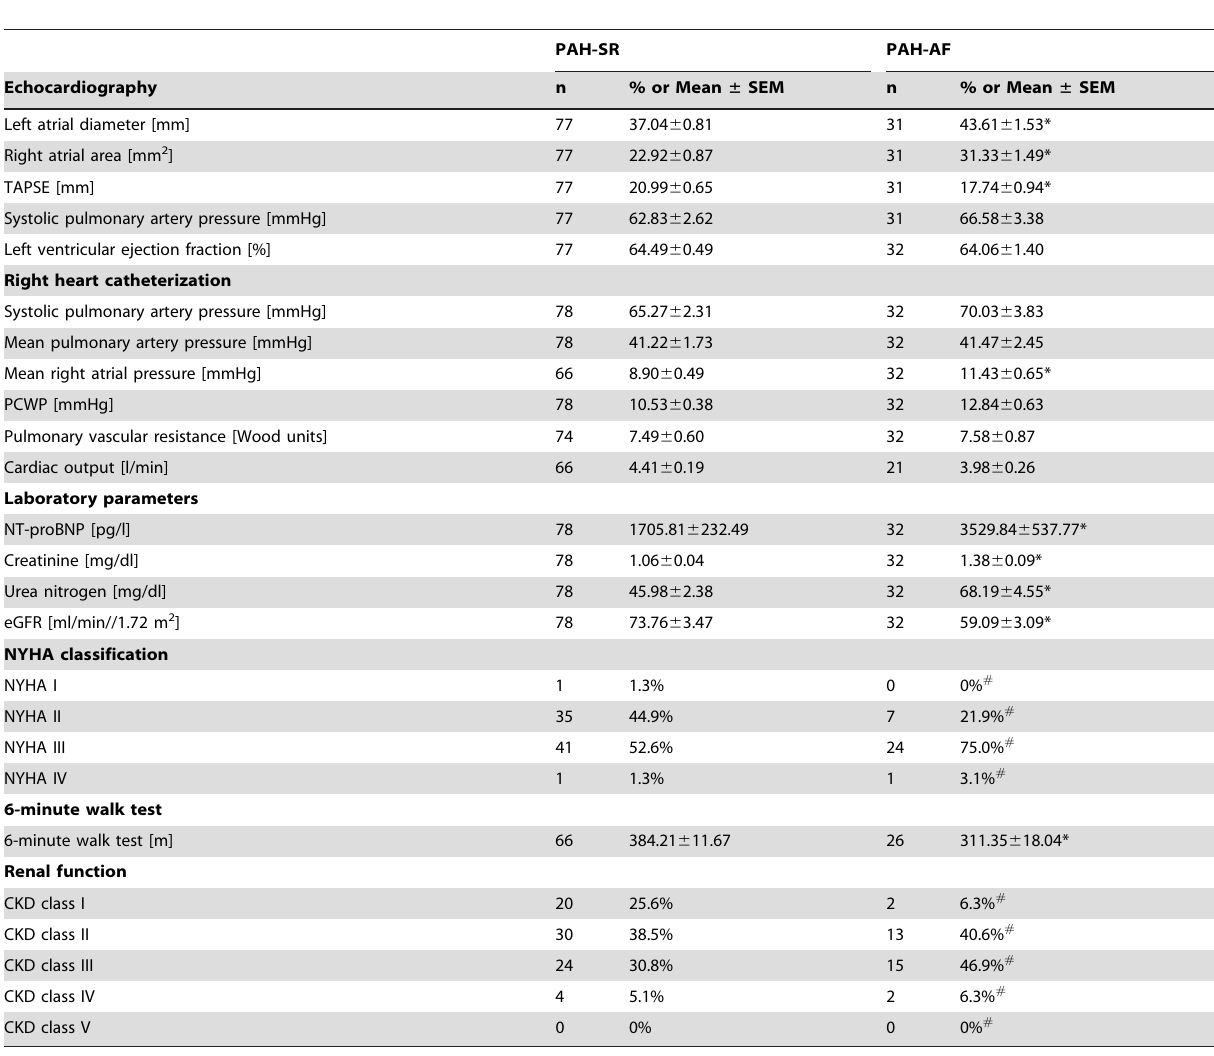
Table 5. Comparison of subgroups with SR vs. AF in PAH.